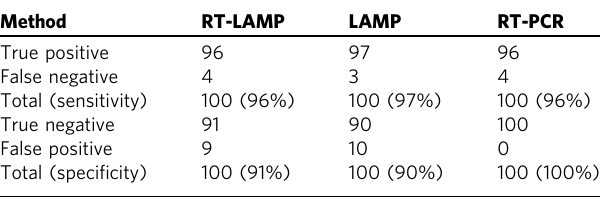
Table 3 Sensitivity and speci fi city of HCV